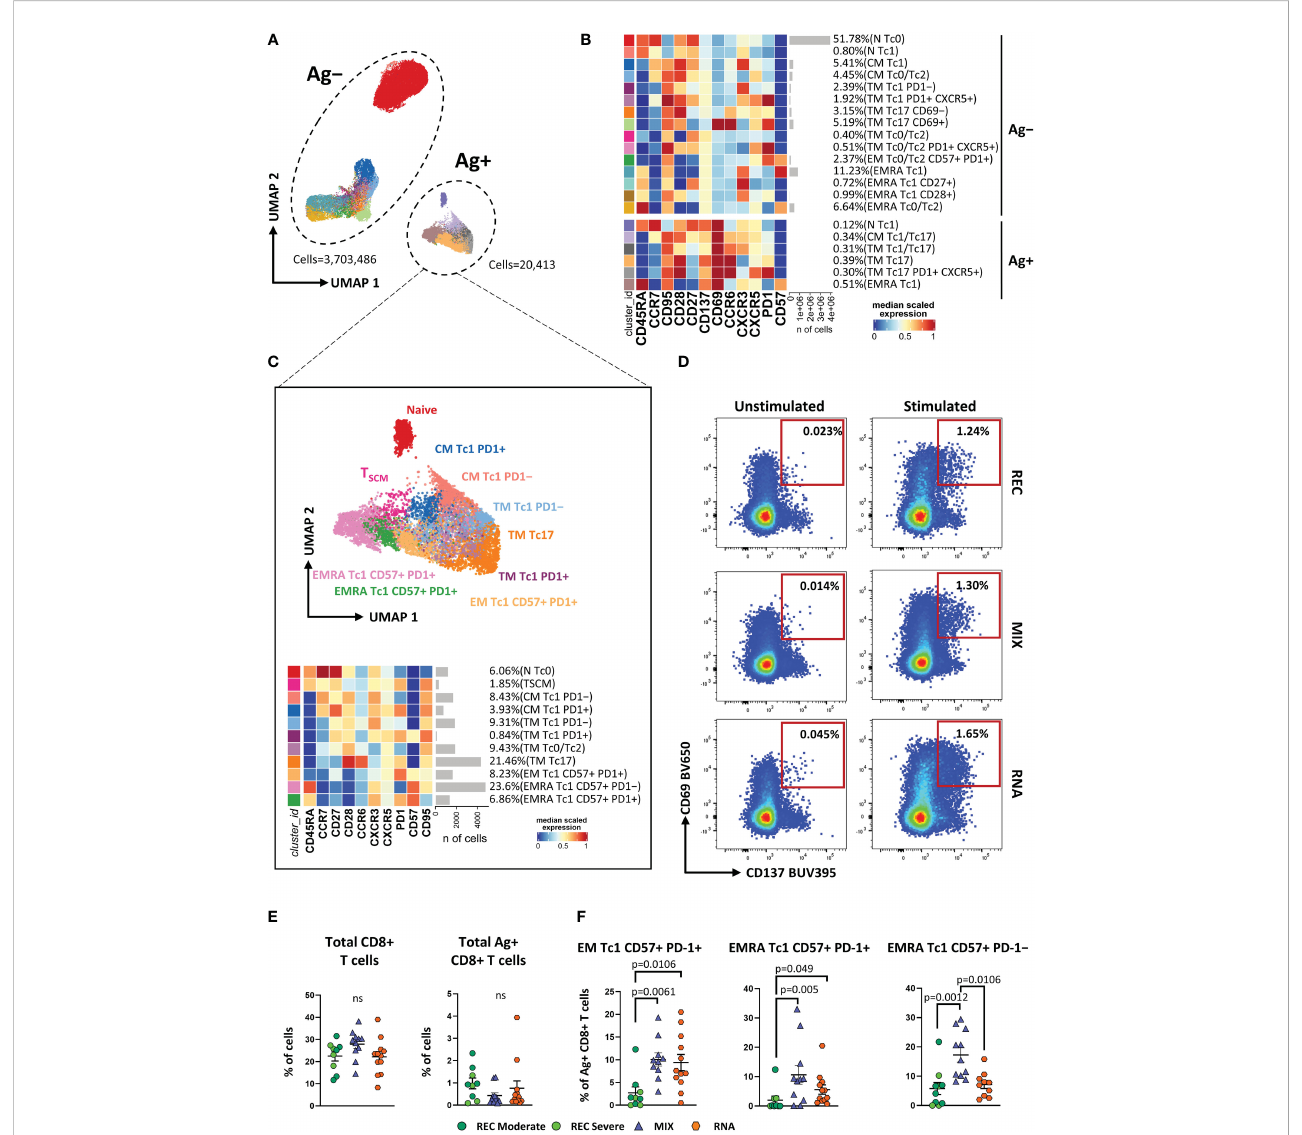
FIGURE 2 Immune phenotyping of antigen-speci fi c CD8 + T cells. (A) UMAP plot shows the 2D spatial distribution of 3,723,899 cells from nine donors who recovered from SARS-CoV-2 infection (REC, severe = 4 and moderate = 5) and 23 vaccinated donors (MIX = 11 and RNA = 12) embedded with FlowSOM clusters. Ag + , antigen- speci fi c CD8 + T cells; Ag − , non-antigen-speci fi c CD8 + T cells. (B) Heatmap of the median marker intensities of the 12 lineage markers across the 21 cell populations obtained with FlowSOM algorithm after the manual metacluster merging. The colors of cluster_id column correspond to the colors used to label the UMAP plot clusters. The color in the heatmap is referred to the median of the arcsinh marker expression (0 – 1 scaled) calculated over cells from all of the samples. Blue represents lower expression, while red represents higher expression. Light gray bar along the rows (clusters) and values in brackets indicate the relative sizes of the clusters. N, naive; CM, central memory; TM, transitional memory; EM, effector memory; EMRA, effector memory reexpressing the CD45RA. The black bar on the right is used to group Ag + or Ag − subpopulations. (C) Uniform Manifold Approximation and Projection UMAP and heatmap visualization of 11 manually merged antigen-speci fi c CD8 + T cell clusters. (D) Representative dot plots showing manual gating analysis of Ag-speci fi c (CD137 + CD69 + ) CD8 + T cells after overnight stimulation with spike protein compared to unstimulated control [activation-induced marker assay (AIM assay)]. Numbers in the dot plots indicate the percentage of cells identi fi ed by manual gating. (E) Dot plots show the total percentage of antigen-speci fi c CD8 + T cells. Kruskal – Wallis test with Benjamini – Hochberg correction for multiple comparisons was used to test the differences among the three groups. (F) Dot plots show the relative cell percentage of the antigen-speci fi c CD8 + T-cell clusters of nine donors who recovered from SARS-CoV-2 infection (REC, severe = 4 and moderate = 5) and 23 vaccinated donors (MIX = 11 and RNA = 12). The central bar represents the mean ± SEM. Generalized linear mixed model GLMM test was used for the statistical analysis. Adjusted P- values are reported in the fi gure. ns, not signi fi